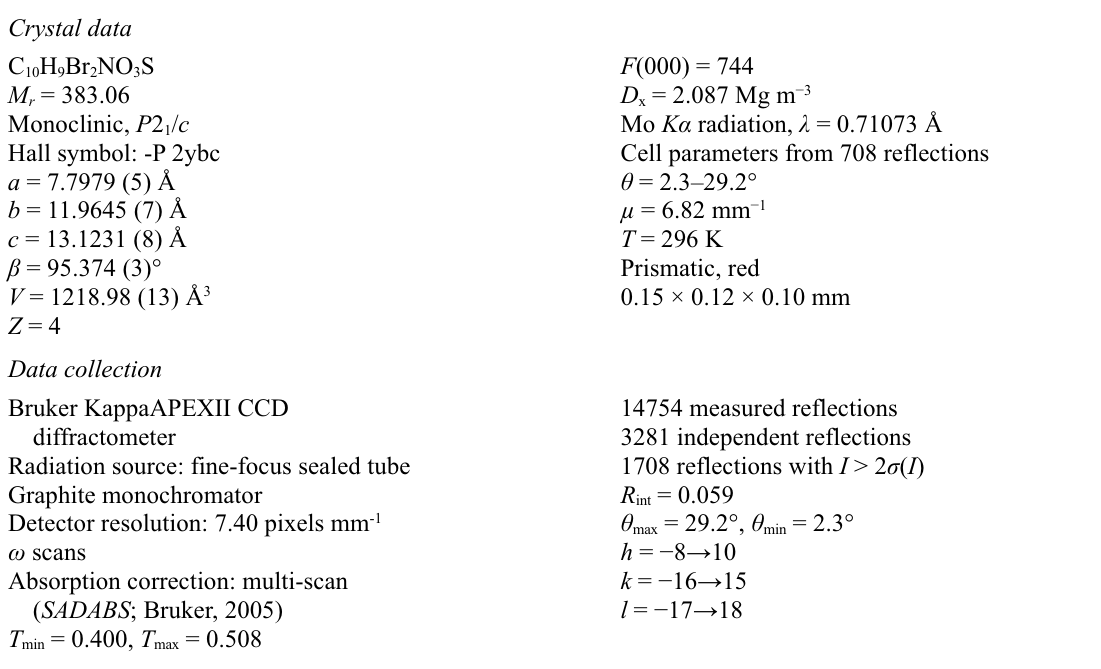
Figure 2 A packing diagram of (I). Hydrogen bonds are shown as dashed lines. 3,3-Dibromo-1-ethyl-1H-2,1-benzothiazin-4(3H)-one